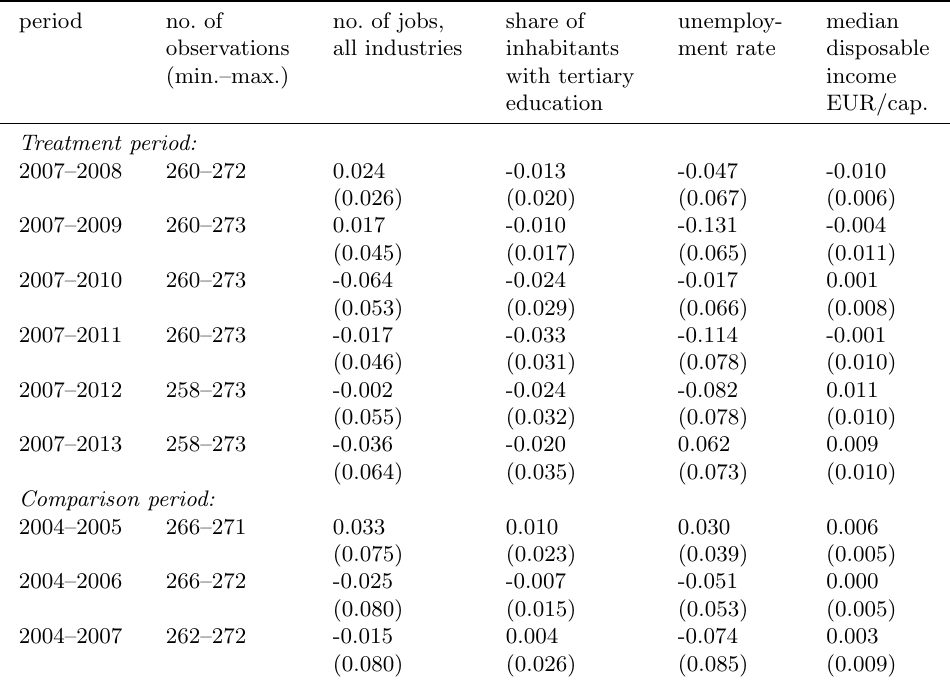
Table A1: Regression coefficients,